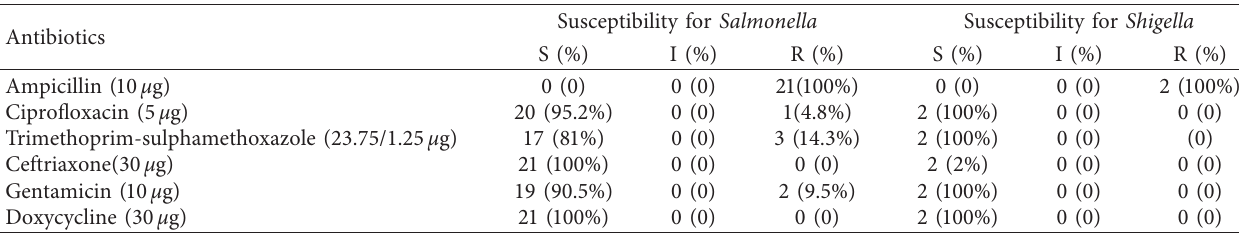
Table 3: Antimicrobial susceptibility pattern of Salmonella and Shigella isolate among street food handlers in Jimma town, southwest Ethiopia, Oct–Dec 2020.